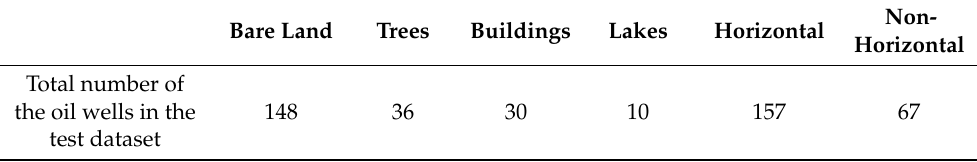
Table 5. Total number of oil wells in the test dataset of different background and orientation.